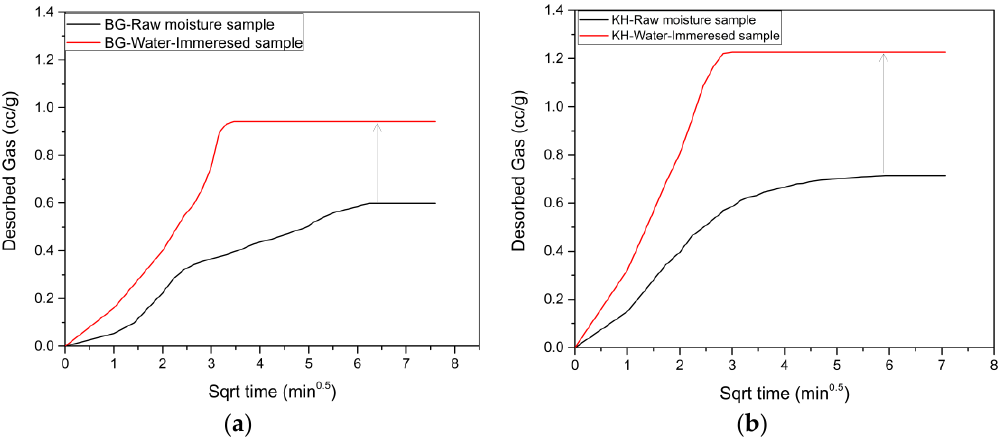
Figure 9. Desorbed gas rate and volume (cc/g) versus (min 0.5 ). ( a ) BG shale sample; ( b ) KH shale sample.